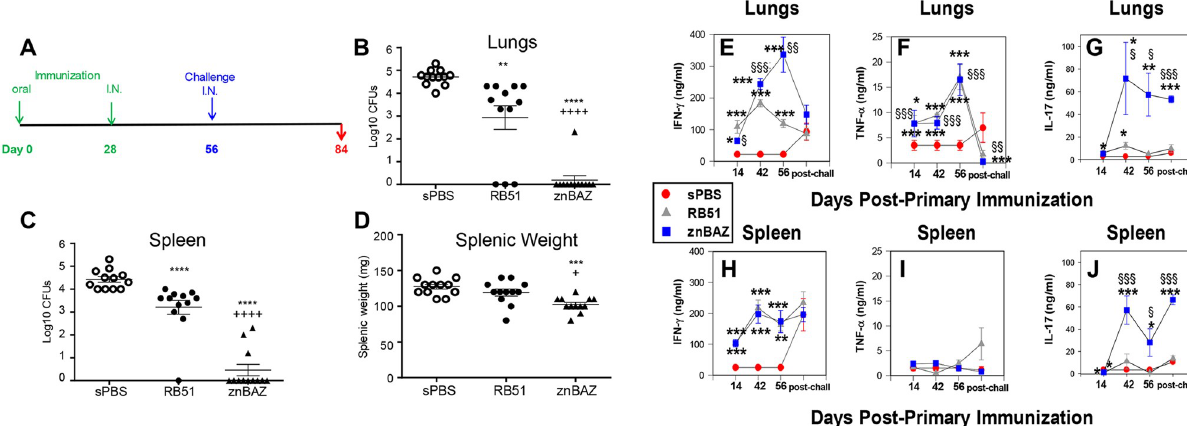
Fig 1. Mucosal znBAZ vaccination and confers superior protection and elicits proinflammatory cytokine production against pulmonary wt B . abortus infection. (A) Groups of BALB/c mice were orally immunized with 1 × 10 9 CFUs of znBAZ, RB51 or sPBS on day 0, and nasally boosted with znBAZ (1 × 10 9 CFUs), RB51 (1 × 10 8 CFUs), or sPBS on day 28. After 4 weeks, mice were nasally challenged with wild-type (wt) B . abortus 2308 (5 × 10 4 CFUs). To assess vaccine efficacy, 4 weeks post-challenge (n = 12 mice/group), (B) lungs and (C) spleens were assessed for colonization and (D) splenic weights. Data are the mean ± SEM of tissue CFU levels and splenic weights from individual mice. Analysis of variance with Two-way ANOVA Tukey’s multiple comparisons test was performed; ���� P < 0.0001, ��� P < 0.001, �� P < 0.01, � P < 0.05, ns indicates not significant versus sPBS-dosed mice; ++++ P < 0.0001 versus RB51-vaccinated mice. (E-G) Lungs and (H-J) splenic lymphocytes were harvested from separate groups of double-vaccinated mice at 14, 42, 56, and 84 days (4 wks post-challenge [post-chall]) post-primary immunization. Lymphocytes were restimulated with HKRB51 for 3.5 days, and collected supernatants analyzed for (E, H) IFN- γ , (F, I) TNF- α , and (G, J) IL-17a. Data depict n = 8 mice per group, and the mean of two independent experiments. The differences were determined when compared to sPBS-dosed mice: ��� P < 0.001, �� P < 0.01, � P < 0.05, or compared to RB51-dosed mice §§§ P < 0.001, §§ P < 0.01, § P < 0.05.